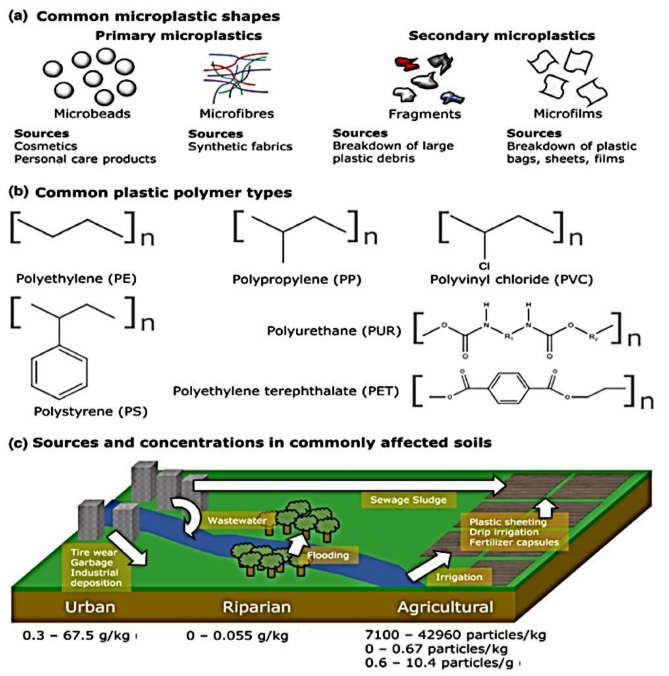
Figure 3. Microplastic forms, shapes, and origins, as well as microplastic concentrations in urban and agricultural soils Reprinted from Helmberger et al. [29] with permission of © (2019)